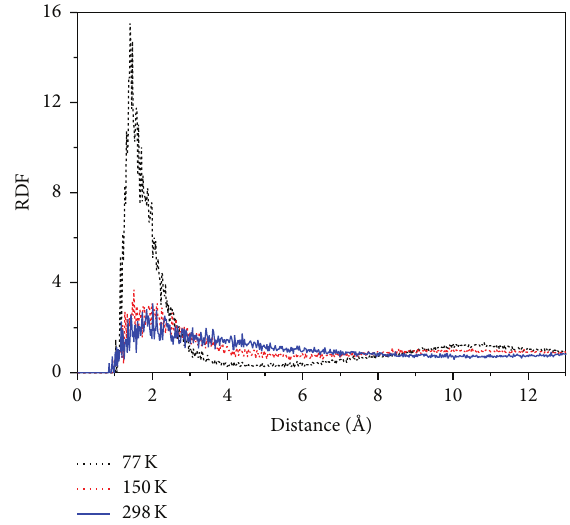
Figure 7: Radial distribution functions of the centers of mass for hydrogen molecules for 77 K and Ca 46 X zeolite at different loading. Figure 8: Radial distribution functions of the centers of mass for hydrogen molecules for 10 molecules/cell and Ca 46 X zeolite at different temperature.